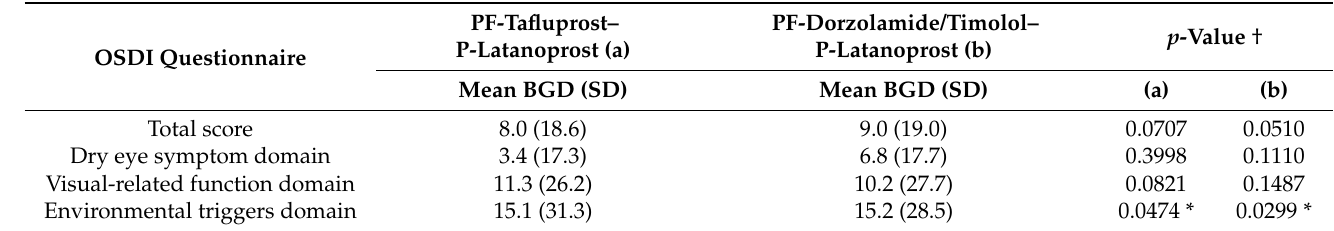
Table 3. Comparison of PF-tafluprost and PF-dorzolamide/timolol with P-latanoprost with respect to the between-group differences in the change in OSDI from baseline to 12-week follow-up in the FAS1 population ( n = 107).